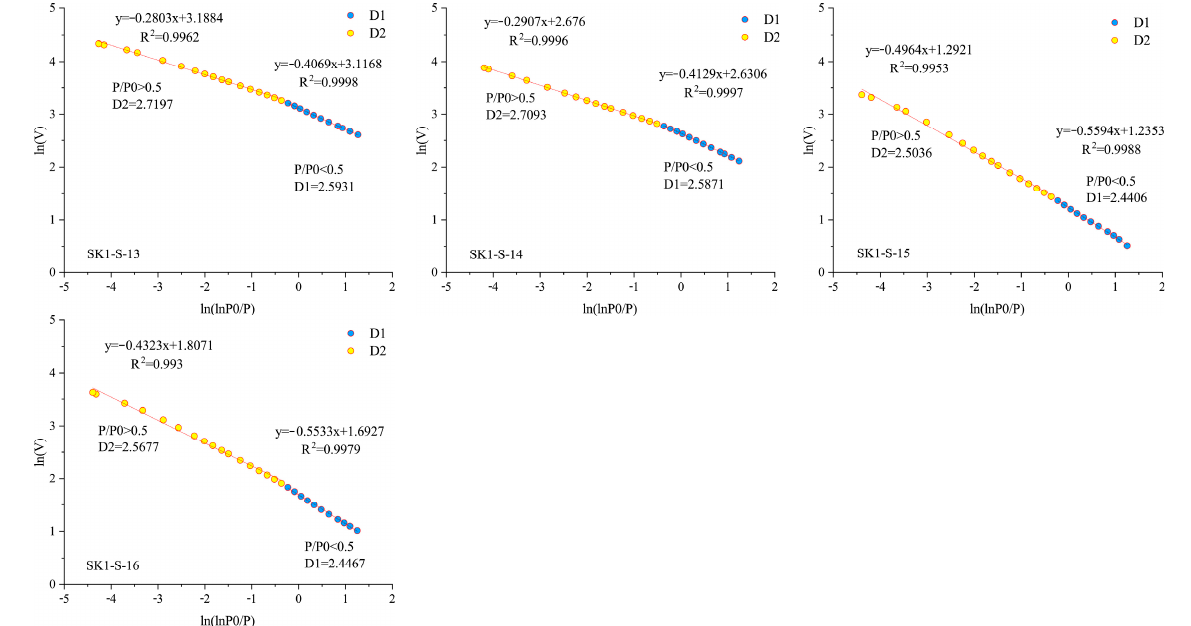
Figure A1. Fractal calculation results from FHH model of N 2 adsorption at low temperature for all samples.